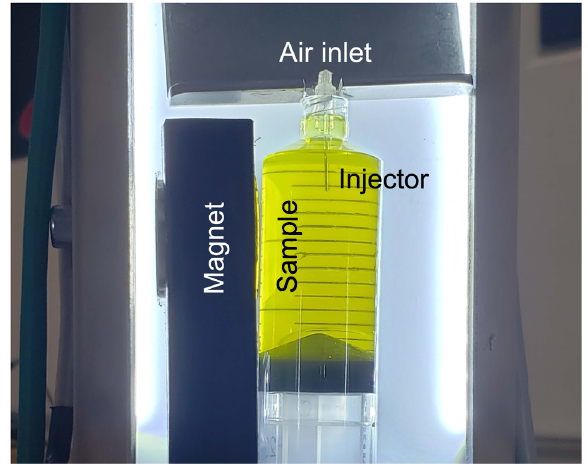
Fig. 7 Details of the syringe sample container with the left magnet con fi guration. Photograph taken by Álvaro Romero-Calvo.